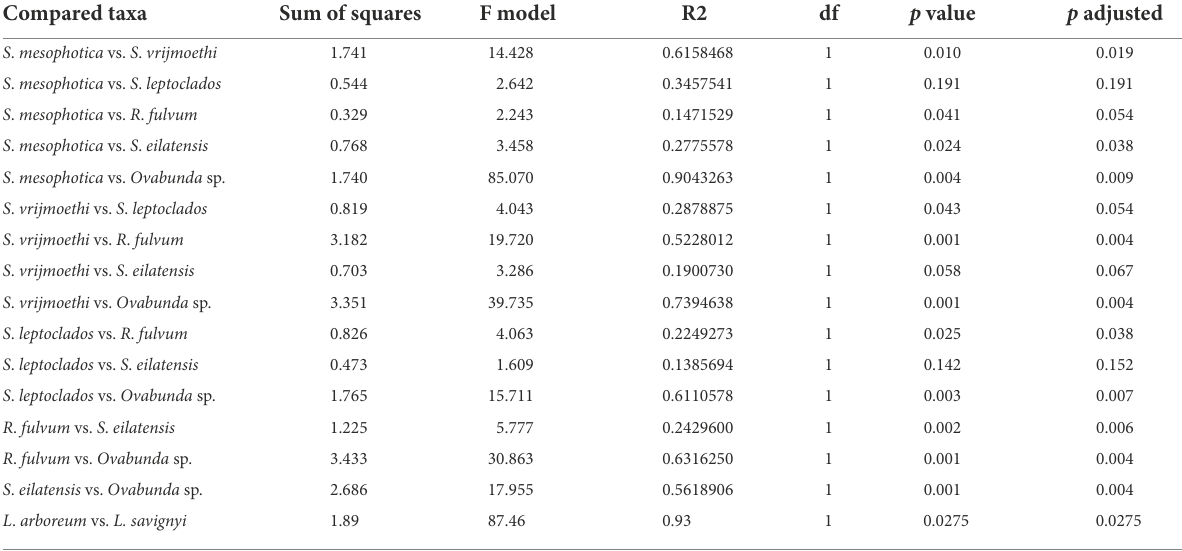
TABLE 3 Results of pairwise permutational multivariate analysis of variance of octocoral species harboring either Cladocopium or Symbiodinium Symbiodiniaceae ITS2 types. Compared